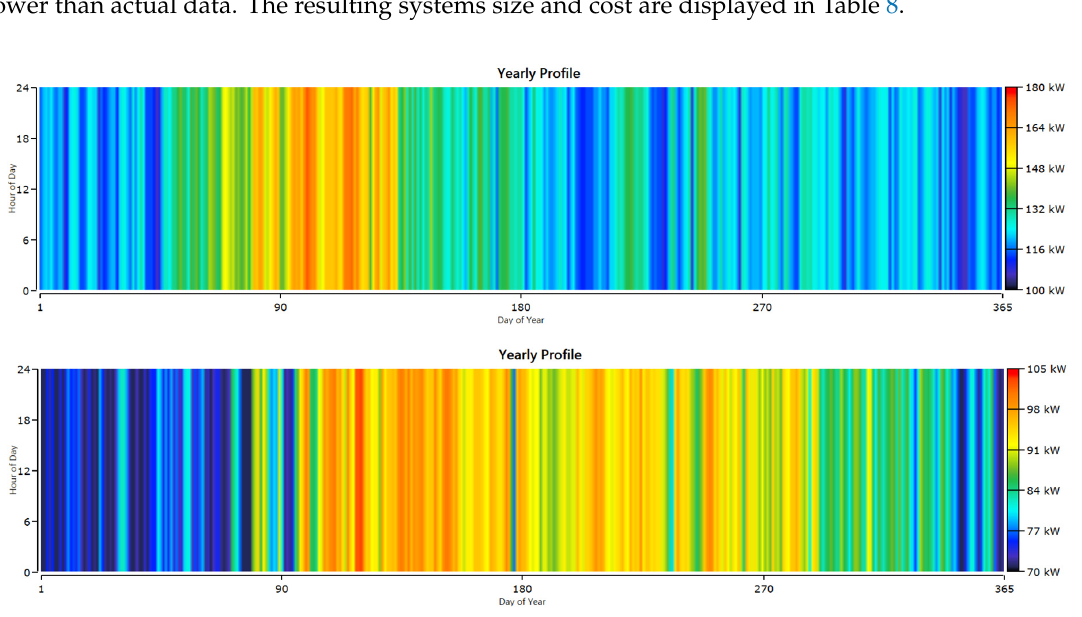
Figure 8. Maximal (top) and minimal (bottom) annual electric load profiles. Table 8. Sensitivity analysis of climate loading extremes, including percent difference ( Δ ) from